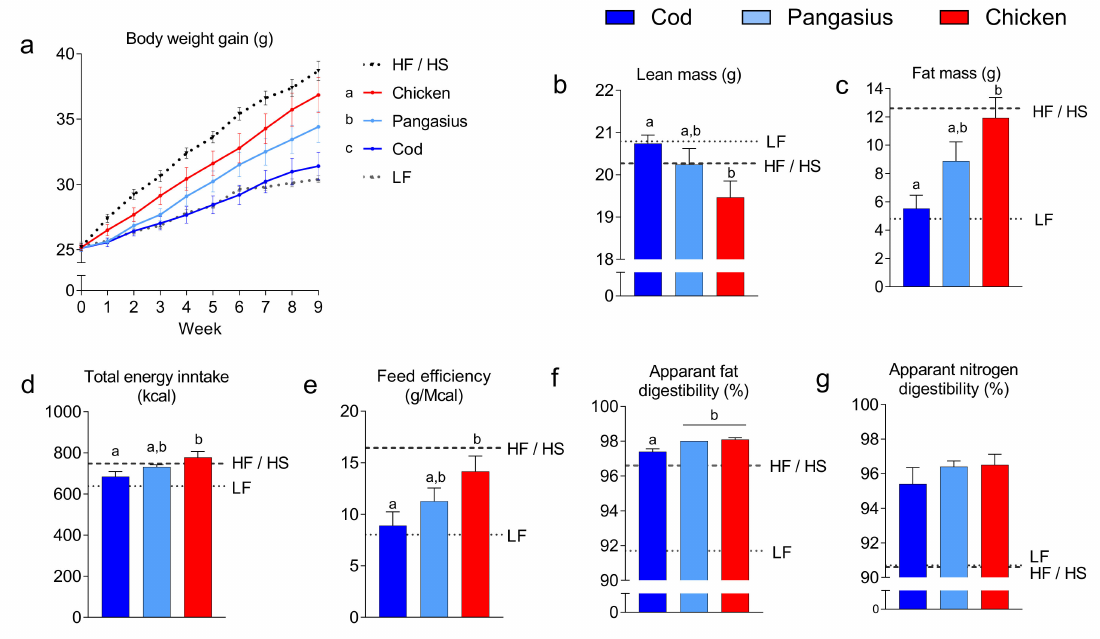
Figure 1. ( a ) Body weight development, ( b ) fat mass and ( c ) lean mass after 9 weeks of ad libitum feeding high-fat / high-protein (HF / HP) diets based on the di ff erent protein sources, in addition to one group fed a low-fat (LF) reference diet and one group fed an obesogenic high-fat / high-sucrose (HF / HS) diet. ( d ) Total energy intake during 9 weeks of feeding. ( e ) Feed e ffi ciency (g / Mcal) from 9 weeks of feeding, calculated as g increased body weight per Mcal eaten. ( f , g ) Apparent fat and nitrogen digestibility measured during the experiment. Data are presented as the mean ± SEM ( n = 10) and di ff erent letters denote significant di ff erences ( p < 0.05) by one-way ANOVA using uncorrected Fisher’s LSD multiple comparison. Body weight development was analyzed by repeated-measure one-way ANOVA and Fisher’s LSD multiple comparison post hoc